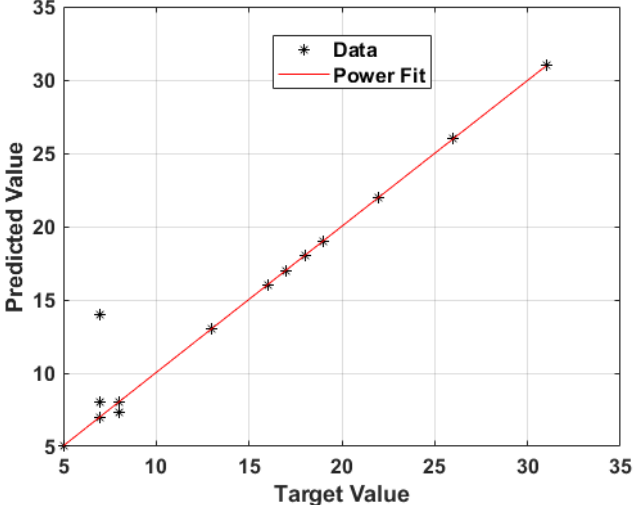
Figure 18. System failure plot of target vs. predicted value for ANN Model 2